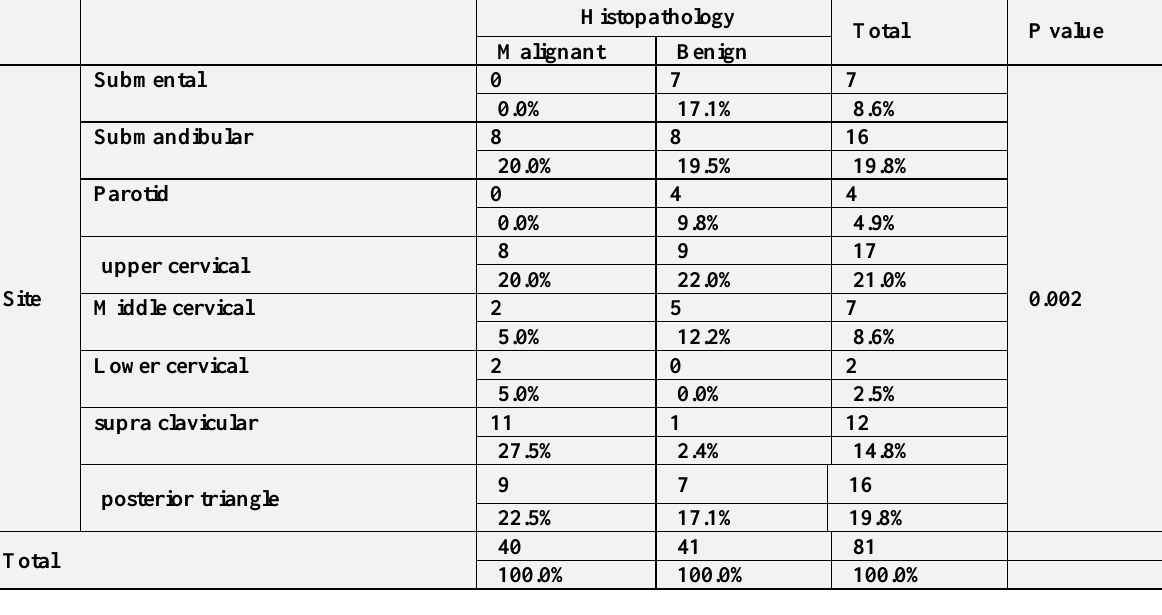
Table (6): ssociation between histopathological findings and site of